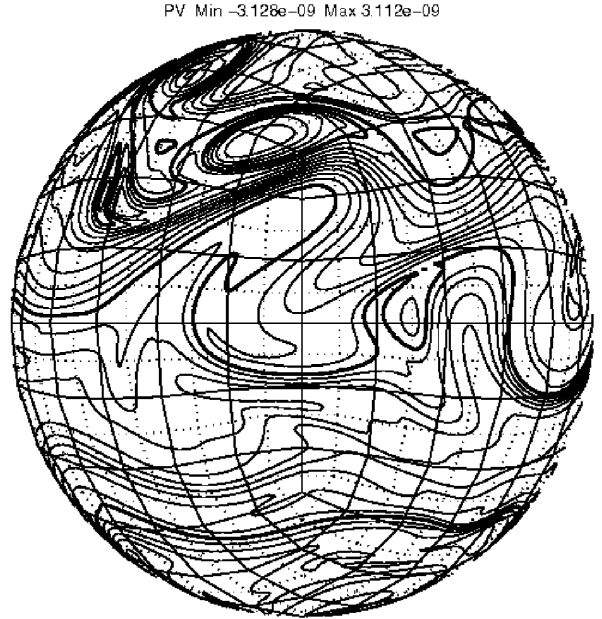
Figure 7. Potential vorticity at day 50 for test case 5 modelled on a cubed-sphere grid of 55296 cells. The contour interval is 2 × 10 − 10 sm − 2 , and the 0 and ± 2 × 10 − 9 contours use double line thickness.